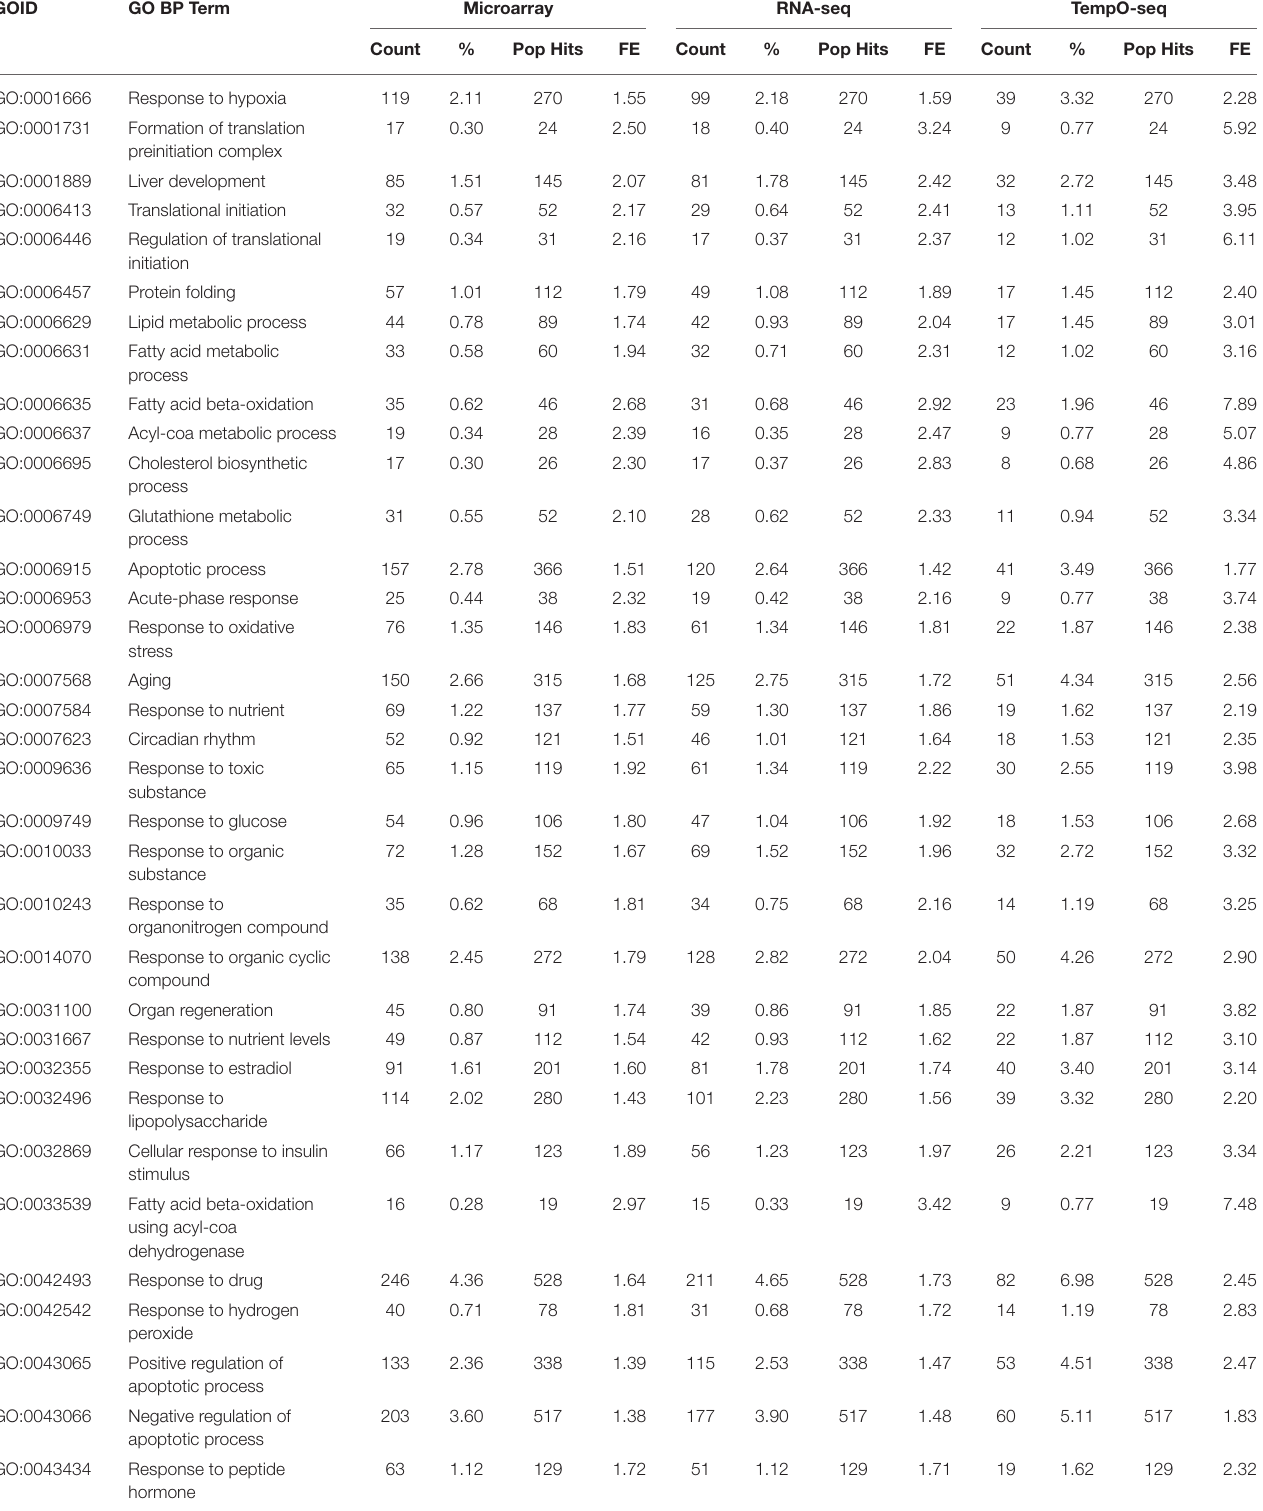
TABLE 4 | Enriched GO BPs (FDR < 5%) that overlap between platforms ®